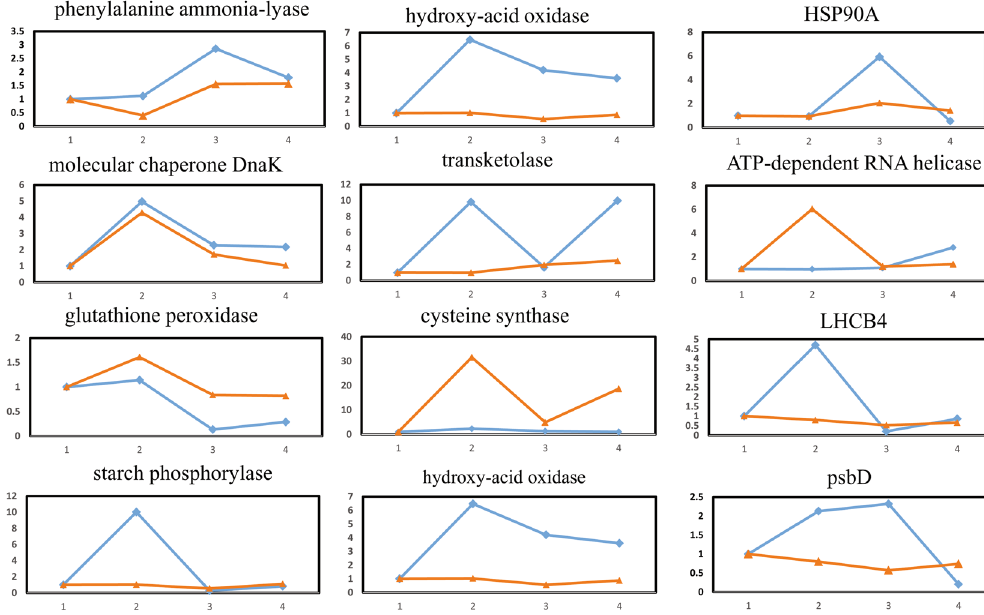
Figure 5. Comparative analysis of the transcript and protein levels of the differentially abundant proteins at two stages of fruit development in ‘Tianyuanhong’ and